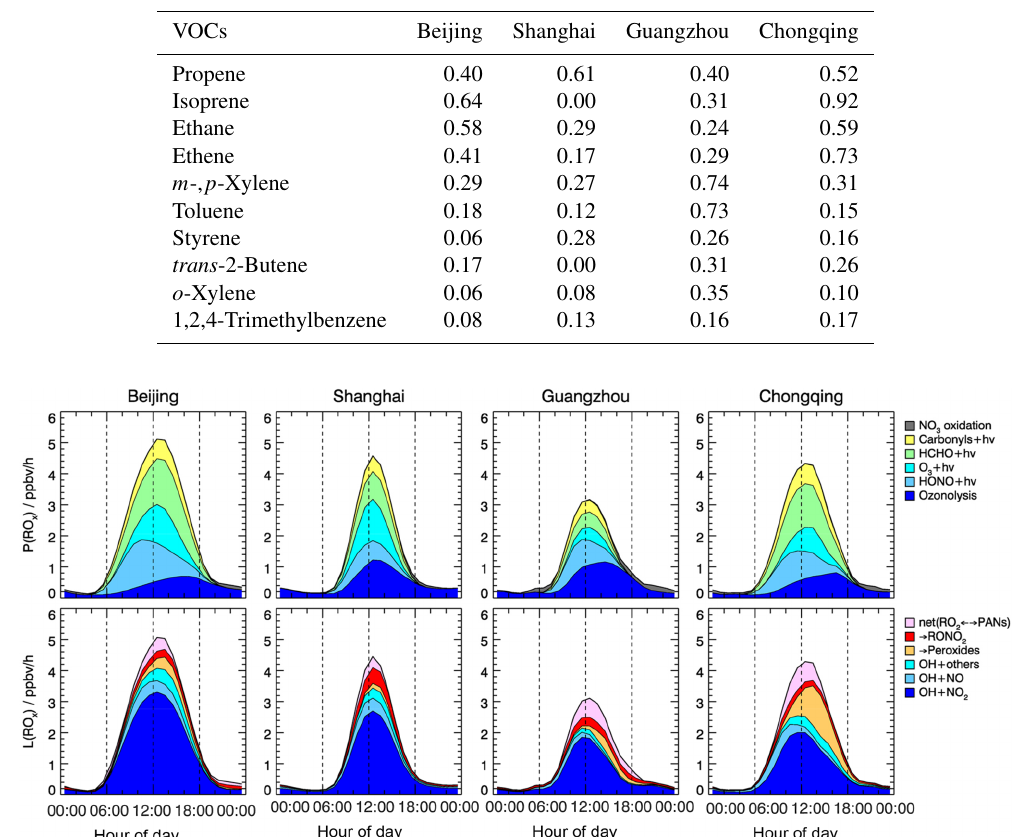
Table 2. The top 10 VOCs’ contribution to OH reactivity during the four campaigns (units: s − 1 ).